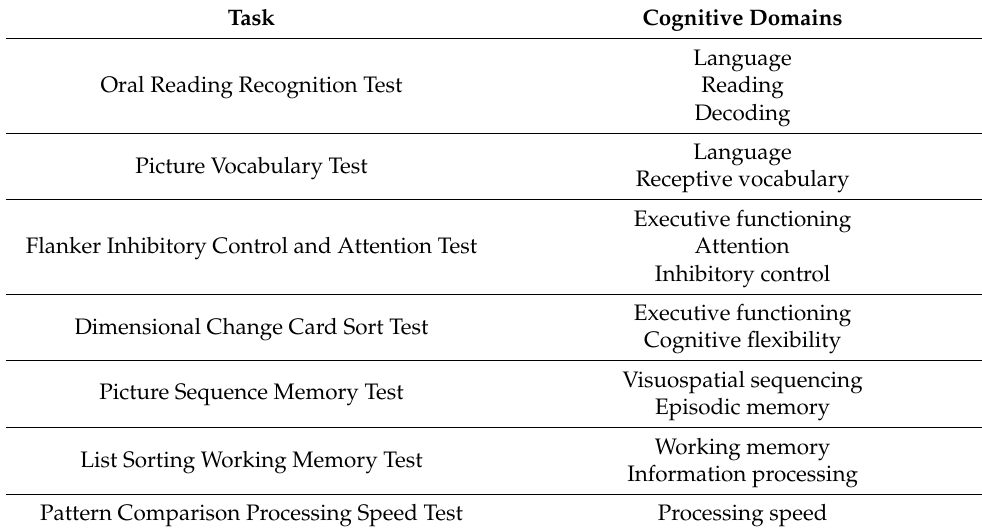
Table 2. Overview of the cognitive measures from the NIH